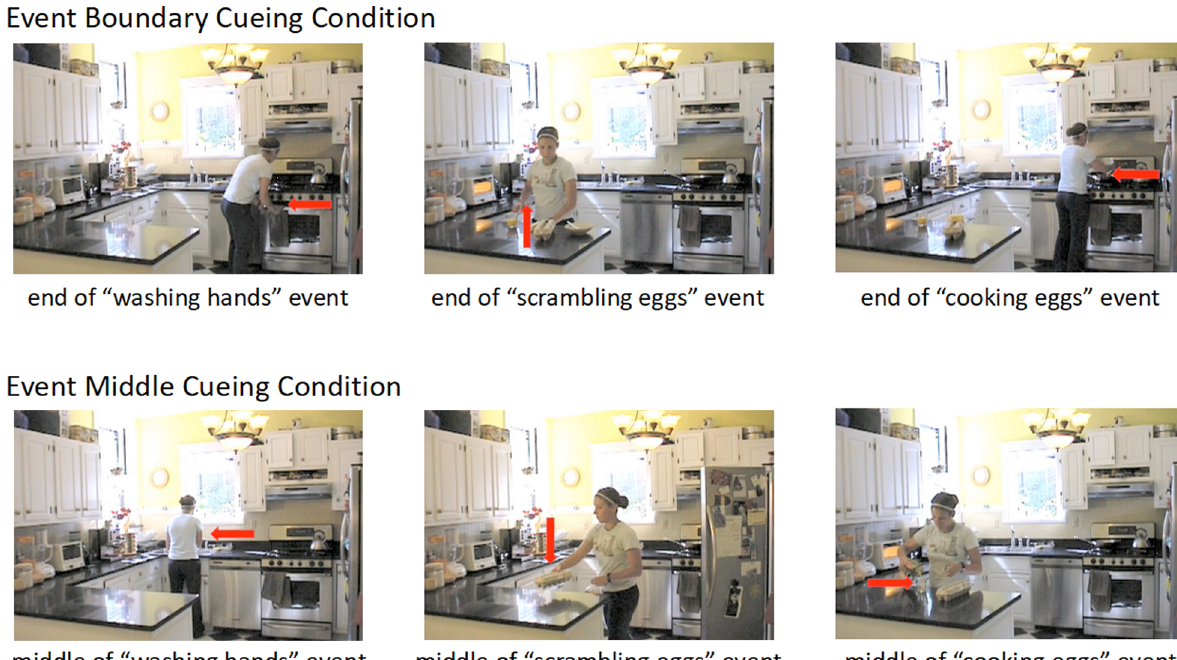
Fig. 1 Examples from the event boundary (top) and event middle (bottom) cueing conditions. Participants experienced a brief slowing of the video, saw an arrow pointing toward the object being interacted with, and heard a bell sound either at an important change (event boundary cueing condition) or in the middle of an unfolding event (event middle cueing